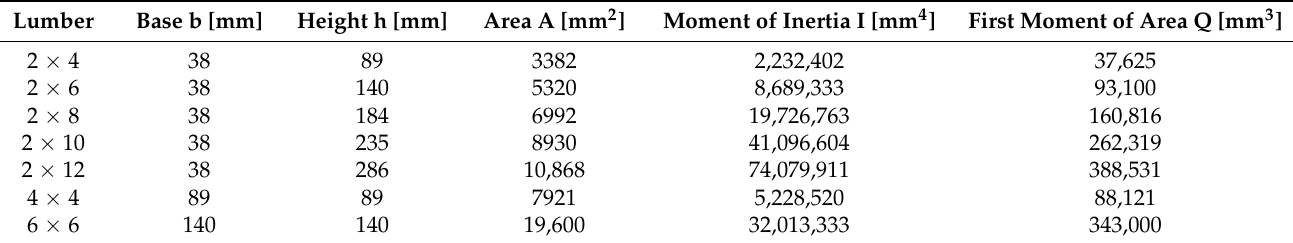
Table 1. Dimensional properties of common sizes of construction